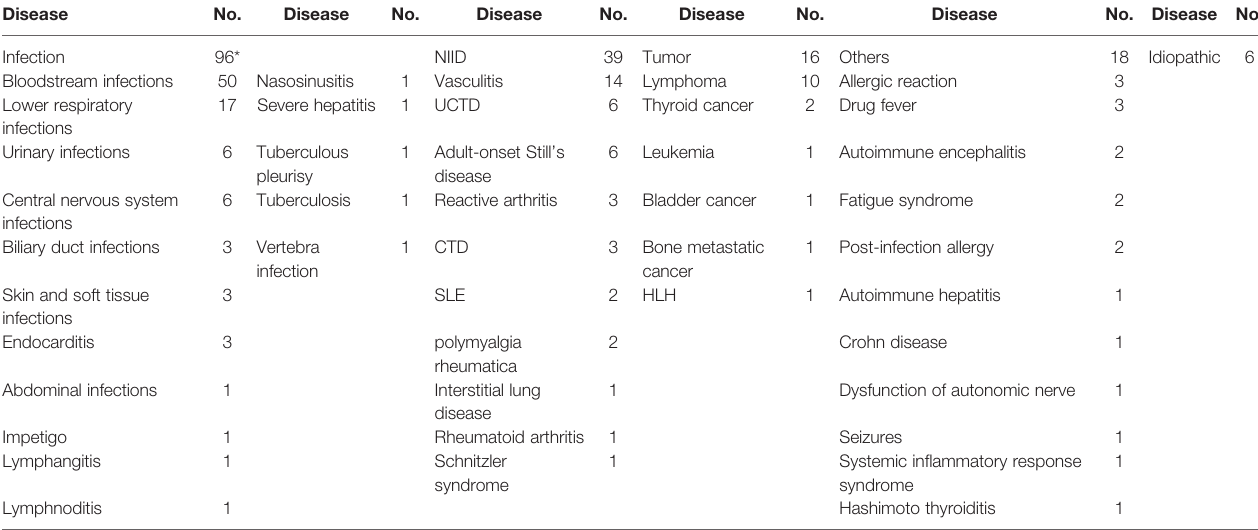
TABLE 1 | Distribution of 175 FUO cases. Disease No.